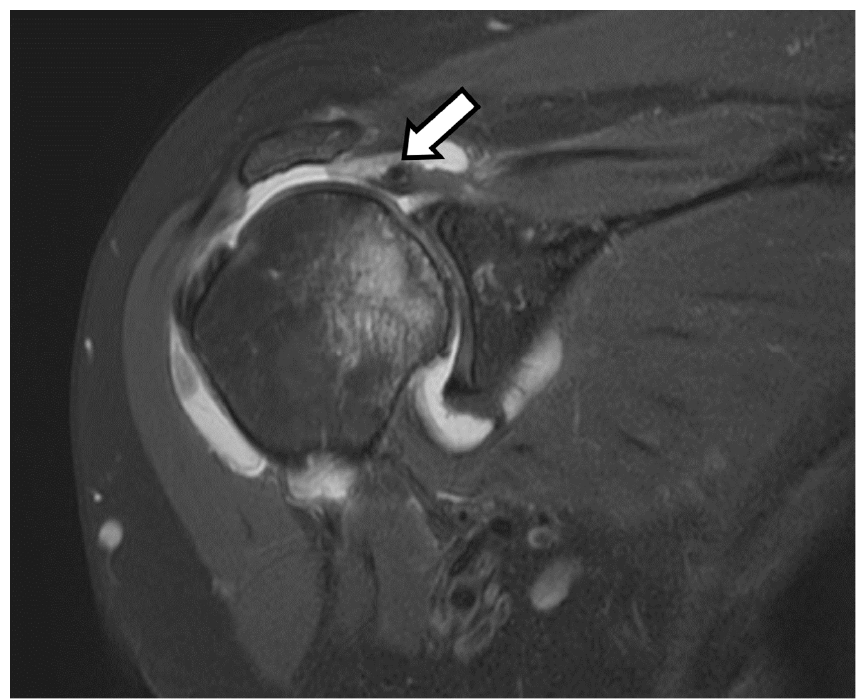
Figure 5. Coronal T2-weighted fat-saturated magnetic resonance (MR) image shows full thickness superior cuff tear with tendon retraction close to the level of the glenoid (arrow). Bone marrow edema and developing cartilage loss along the humeral head is consistent with developing cuff tear arthritis.